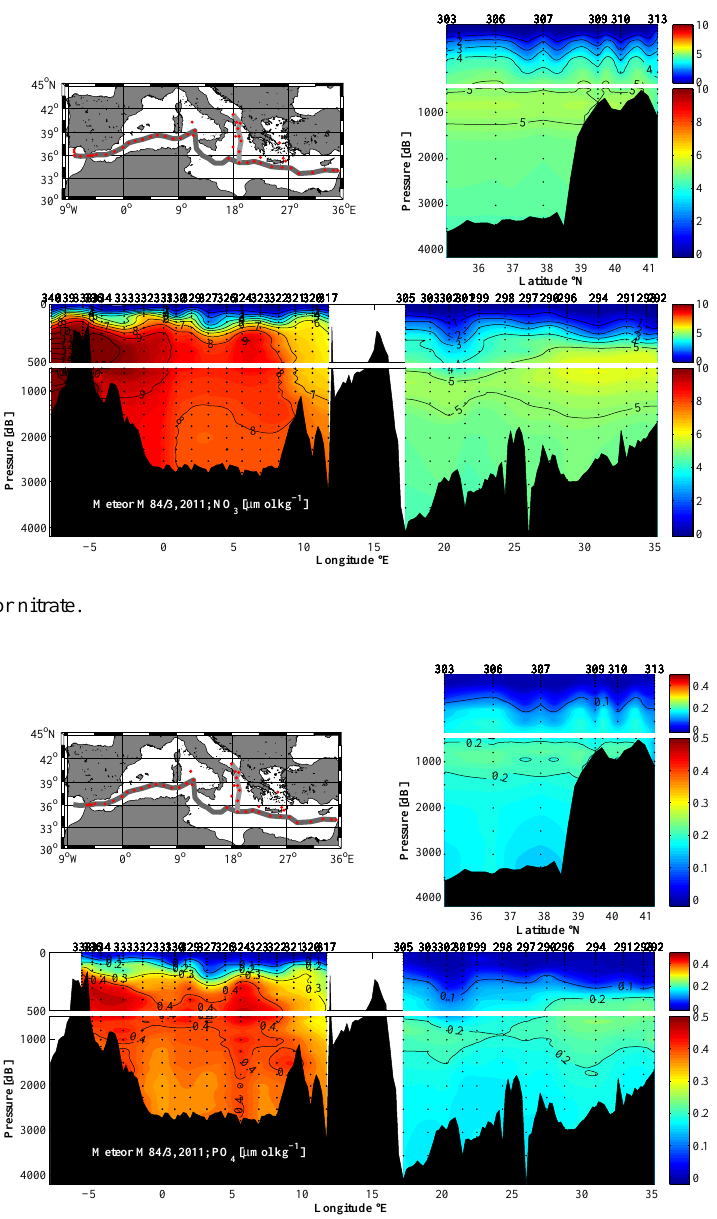
Fig. 8. Similar to Fig. 3, but for phosphate. No stations are shown in the Atlantic due to the very different phosphate values encountered there as compared to the Mediterranean